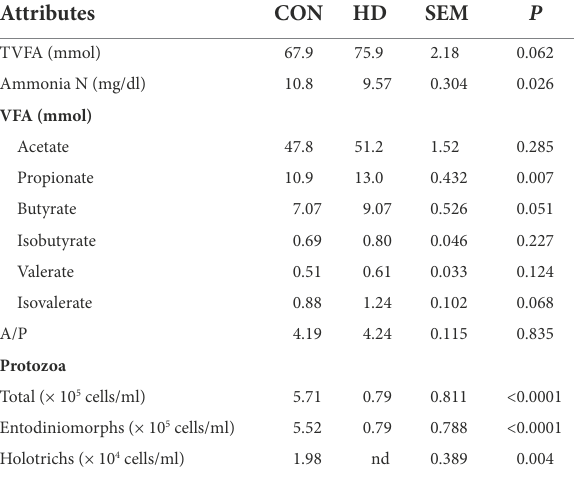
TABLE 4 Effect of anti-methanogenic supplement on rumen fermentation and protozoa in sheep.